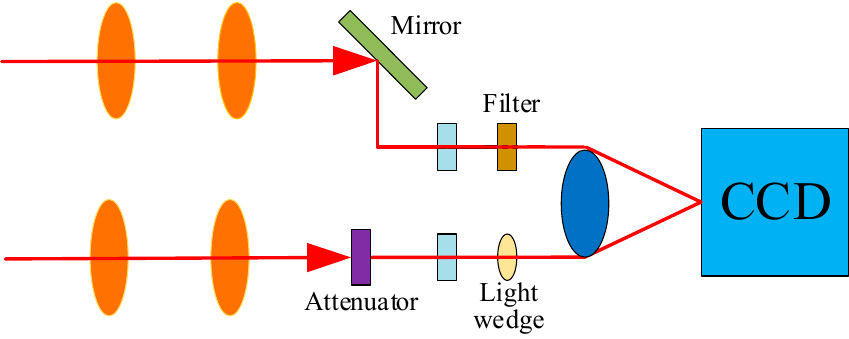
Figure 4. Sketch of the DIMM.